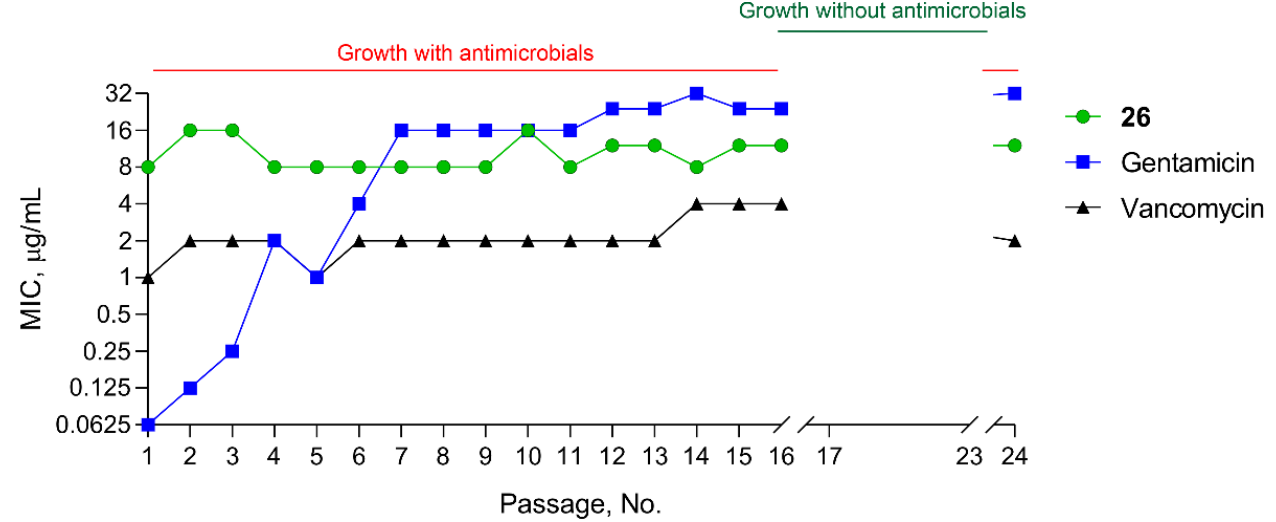
Figure 6. Development of S. aureus resistance to compound 26 (green line), gentamicin (blue line), or vancomycin (black line). Sequential passages 1 to 16 were performed in the presence of antimicrobial agents at sublethal concentrations, followed by seven passages without treatment, and the MIC was determined after each passage. The median values from five independent experiments are shown.